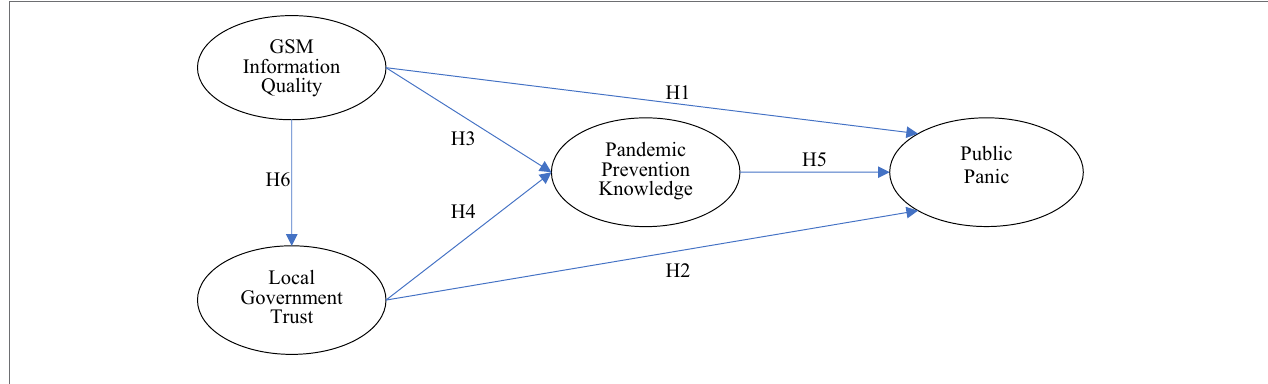
FIGURE 1 | The research